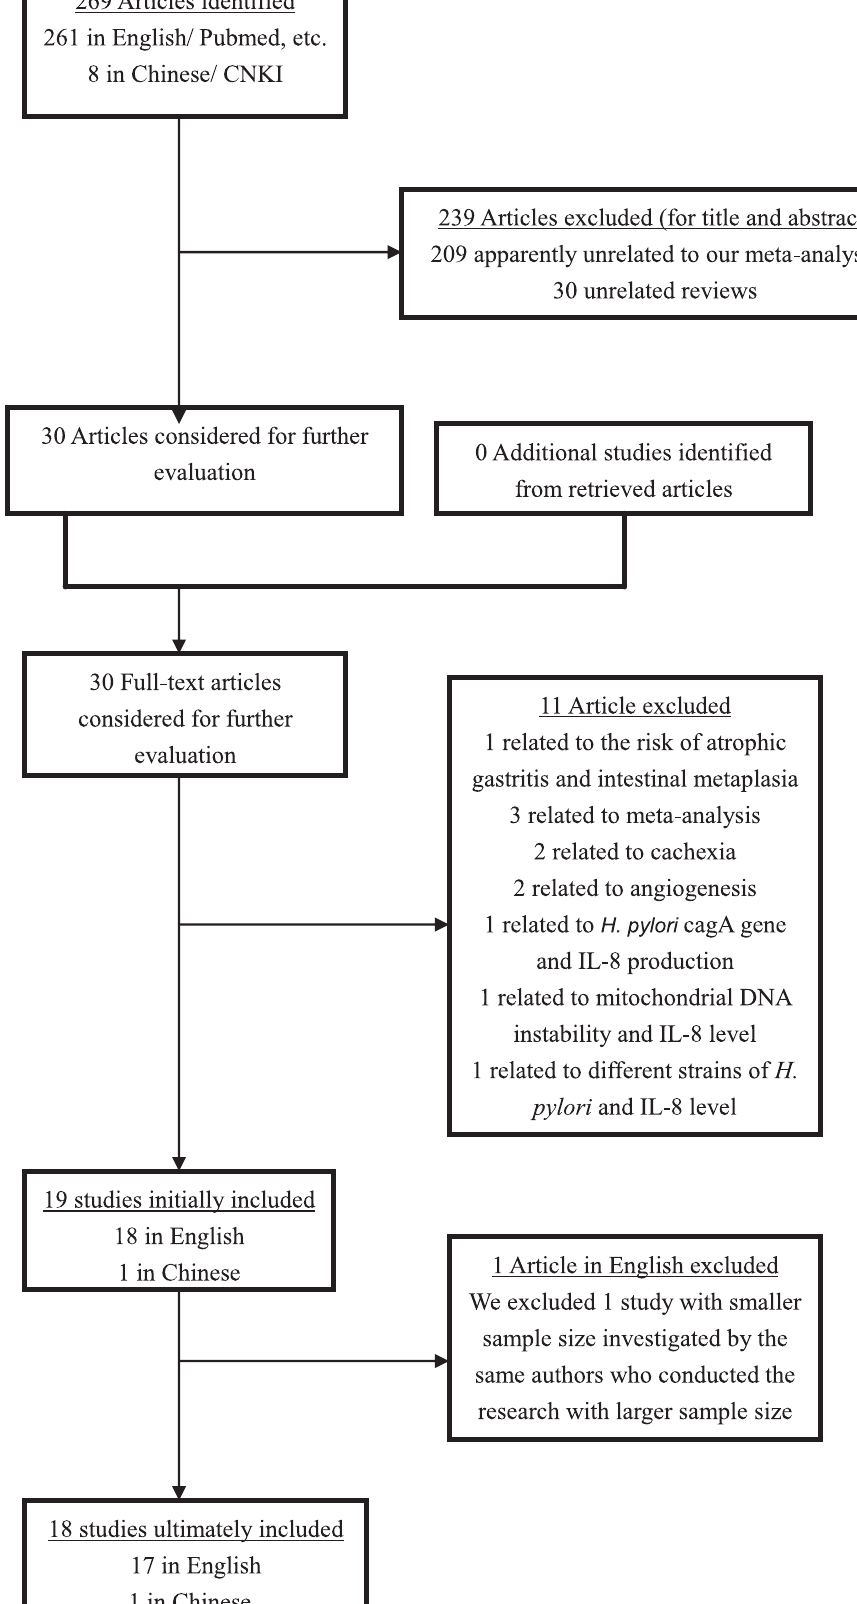
Figure 1. The flow chart of literature search and study selection. doi:10.1371/journal.pone.0028083.g001 PLoS ONE |